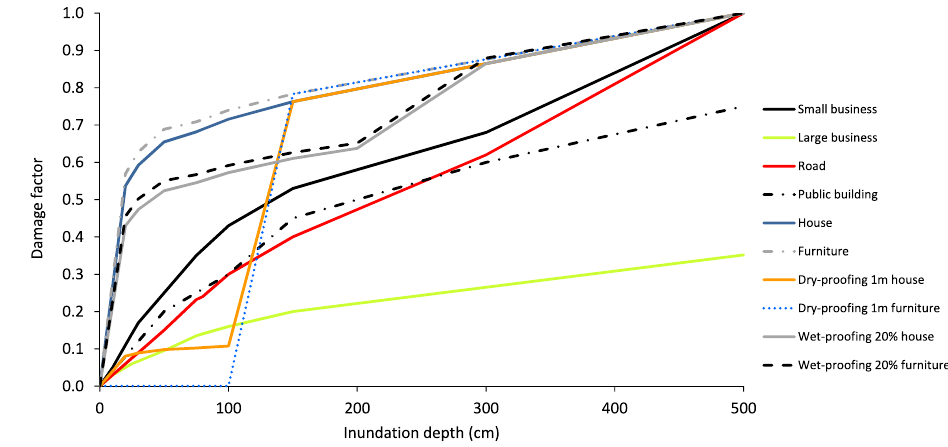
Figure 3. Stage–damage curves as used in this study, including the stage-damage curves for dry- and wet-proofing. Table 1. Maximum damage and damage factors (%) percm inundation depth. LU class